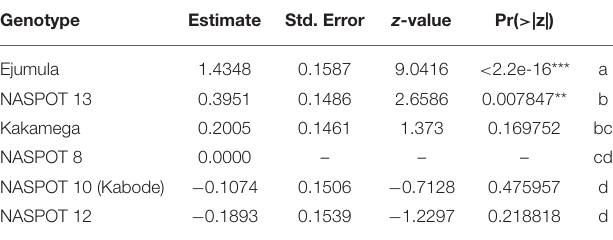
TABLE 5 | Plackett-Luce Model estimates from genotypes tested in Uganda. Genotype Estimate Std. Error